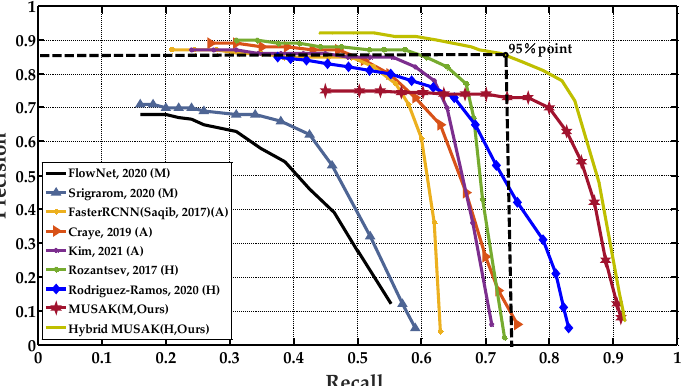
Figure 11. Methods comparison by PR curves (M: motion-based method; A: appearance-based method; H: hybrid method).